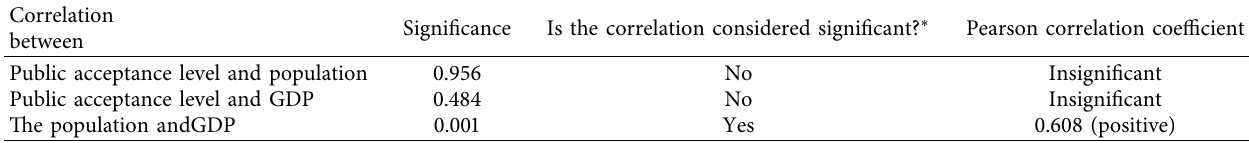
Table 6: Te calculation results of the correlation test between the acceptance level, total population, and GDP.